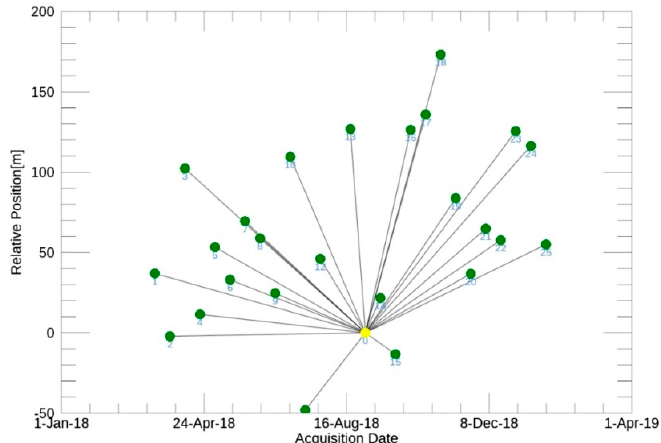
Figure 4. Interferometric pairs selected for PSI (Persistent Scatterer Interferometry) analysis; green dots correspond to the S1-B scenes and yellow dot corresponds to the reference scene (31 August 2018).